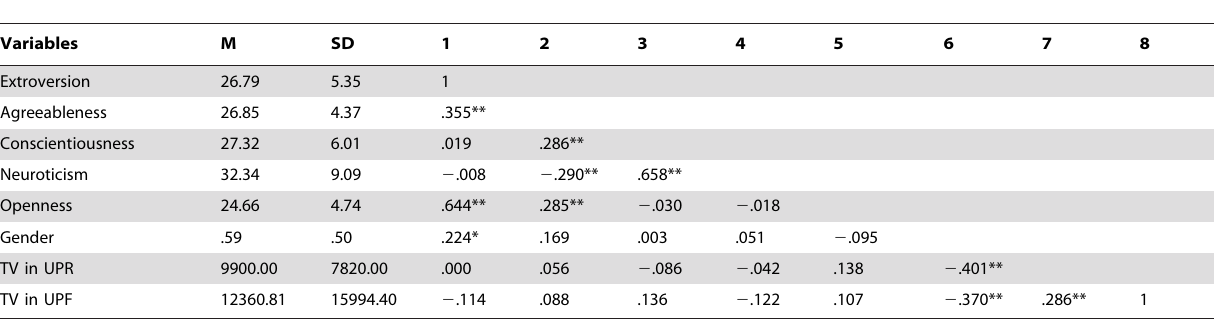
Table 3. Descriptive Statistics and Correlation Analysis.